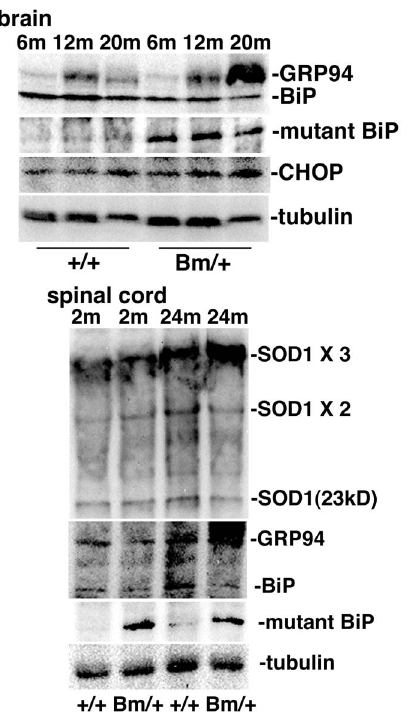
Figure 5. The expressions of chaperones in the mutant BiP mice. The heterozygous mutant BiP mice and the litter mate wild type mice were anesthetized by pentobarbital, and the brains and spinal cords were removed. They were subjected to Western blot analysis with an anti-KDEL mouse mAb for BiP and GRP94, an anti-HA mouse mAb for mutant BiP, an anti-CHOP rabbit antiserum, and an anti-SOD1